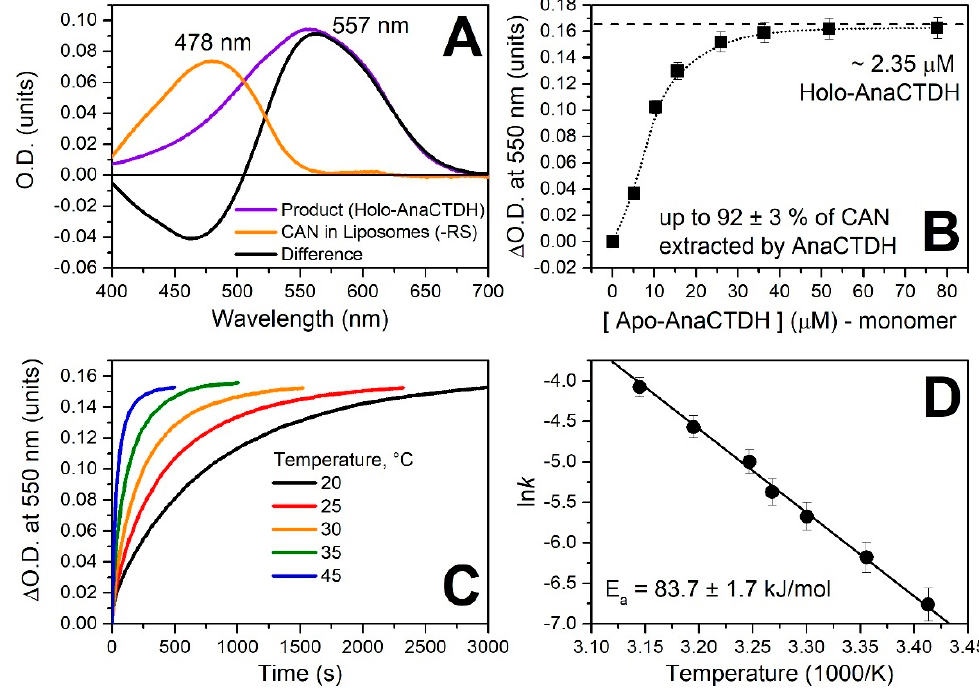
Figure 2. CAN uptake by the AnaCTDH apoprotein from liposomes in PBS (pH 7.4). ( A ) Absorption spectra of CAN in liposomes and after incorporation into AnaCTDH. Rayleigh scattering (RS) was subtracted. ( B ) Increase of O.D. at 550 nm upon addition of different amounts of the AnaCTDH apoprotein to CAN-containing liposomes. ( C ) Time-courses of AnaCTDH holoprotein accumulation due to ECN uptake from liposomes at different temperatures. ( D ) The corresponding temperature dependency of rate constants (Arrhenius plot). All values are presented as mean values ± SD from three independent experiments.